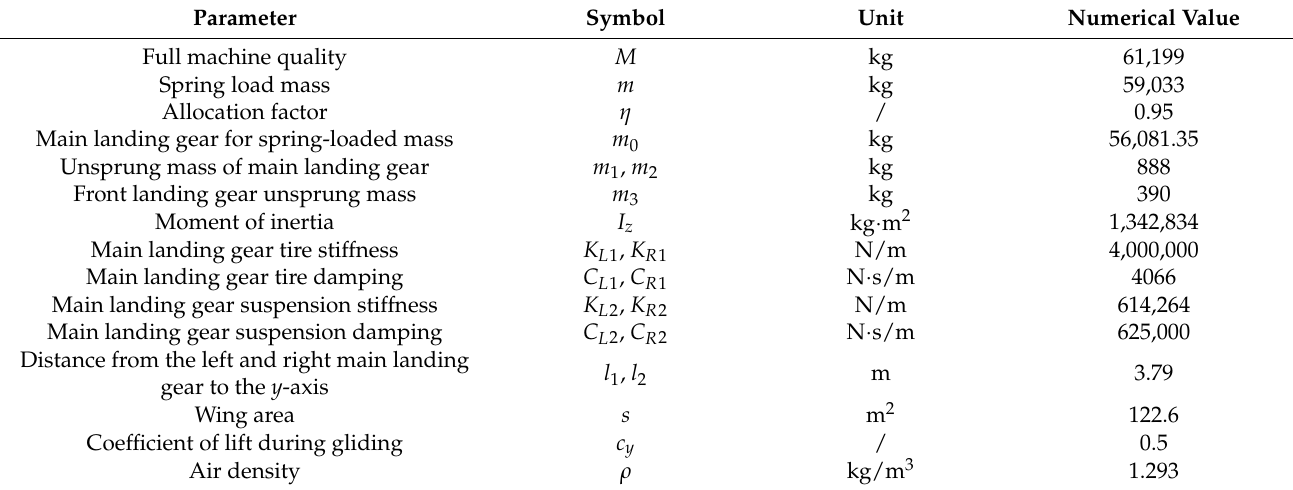
Figure 4. Simulation model of aircraft – runway vibrations. Table 3. Parameters of vibration model of Airbus A320 [34,35].